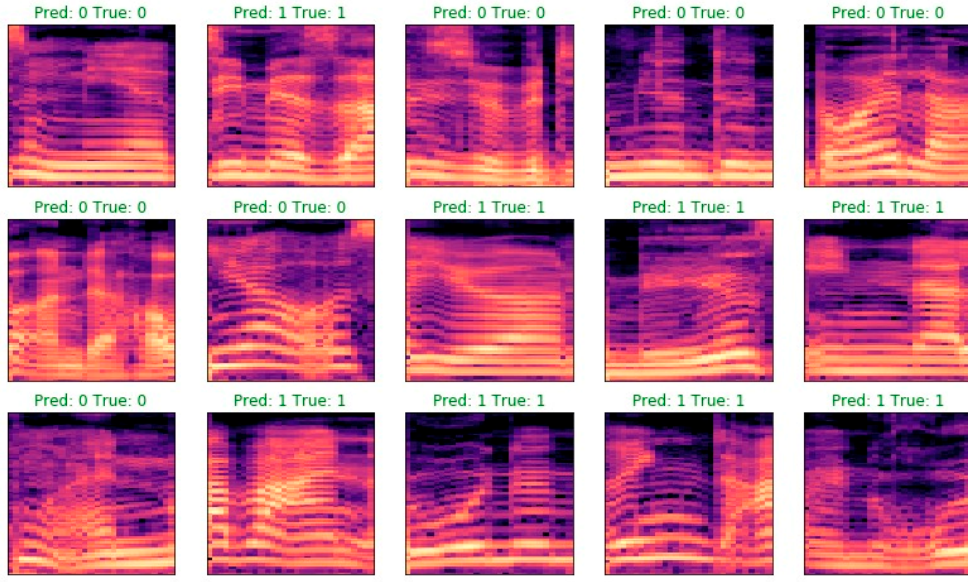
Figure 6. Examples of classifications for Experiment 8. Experiment 9. Experiment 8 repeated without augmentation.